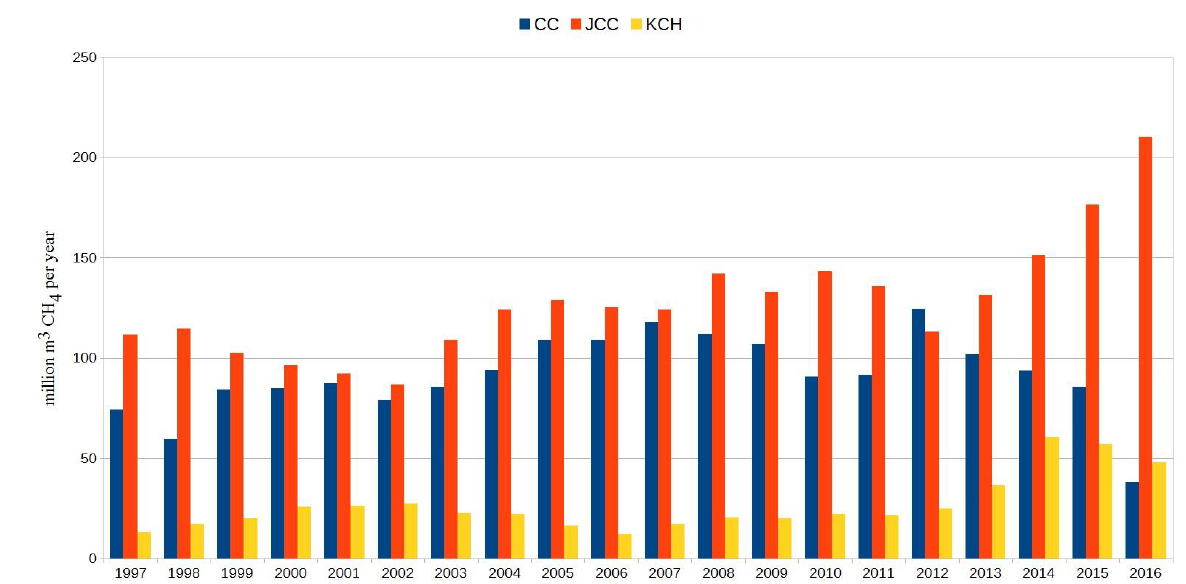
Fig. 9. Amounts of degassing by coal